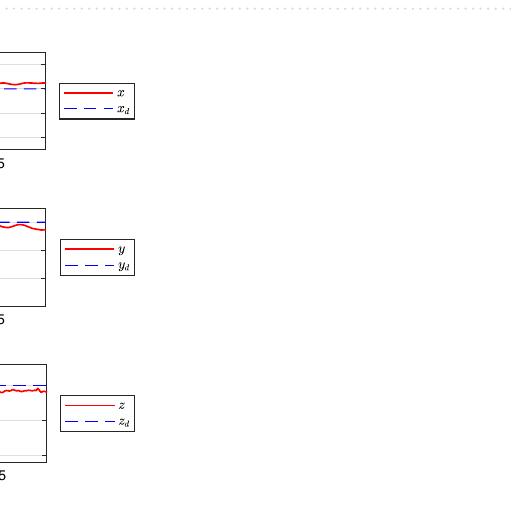
Figure 13. The profile of φ , θ and ψ in the experimental test using NAS.